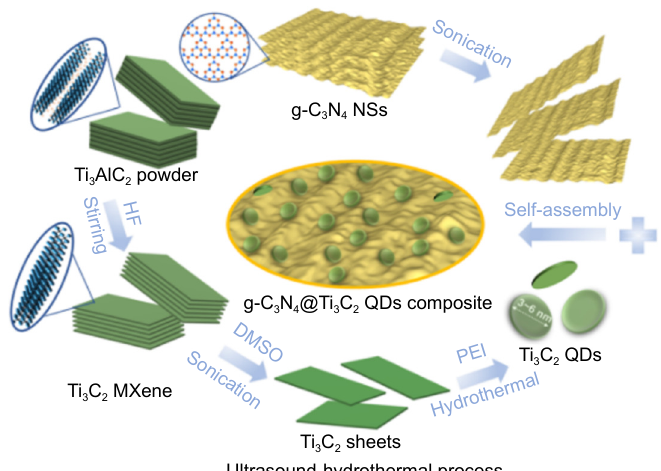
Fig. 3 | Solvothermal/hydrothermal-ultrasound synthesis process. The figure was reproduced from: ref. 66 , Copyright 2019, American Chem- ical